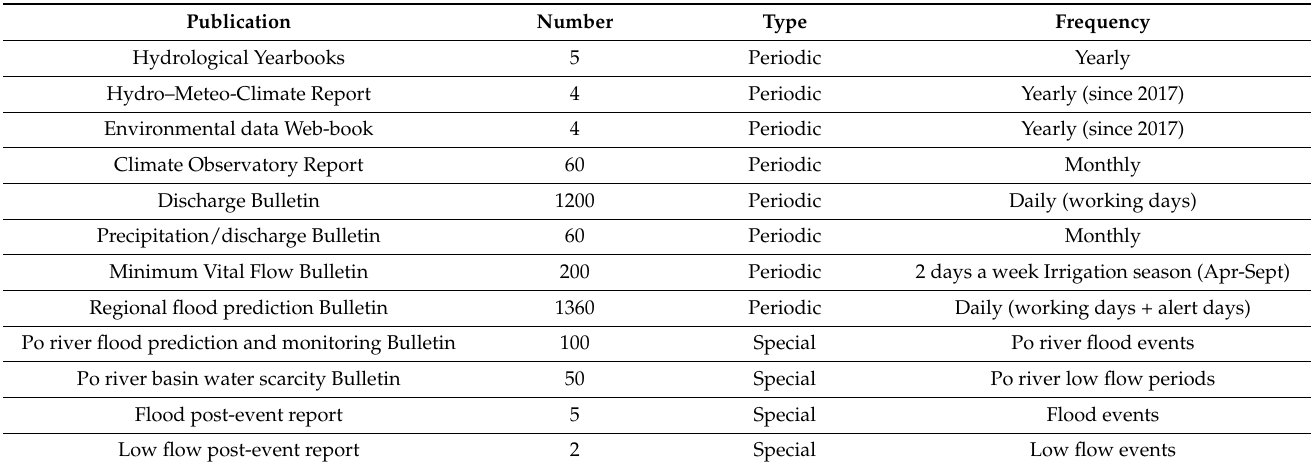
Table 1. Report published between 2016 and 2020 including hydrological